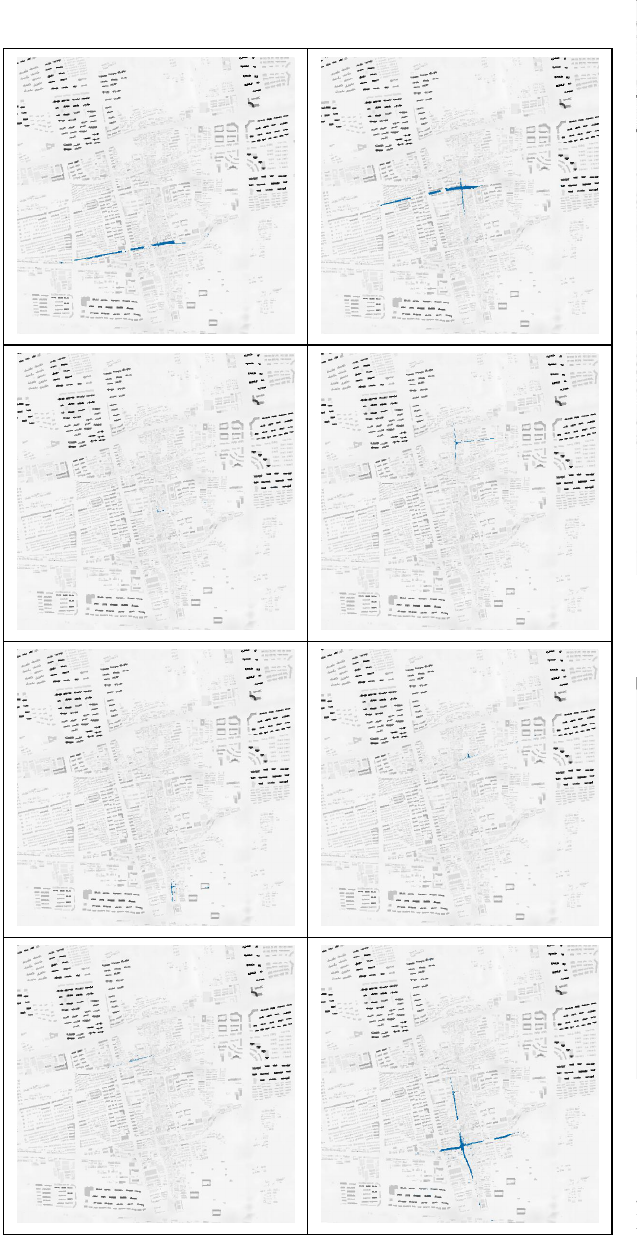
Table 5 . The viewshed maps from landscape corridors and nodes